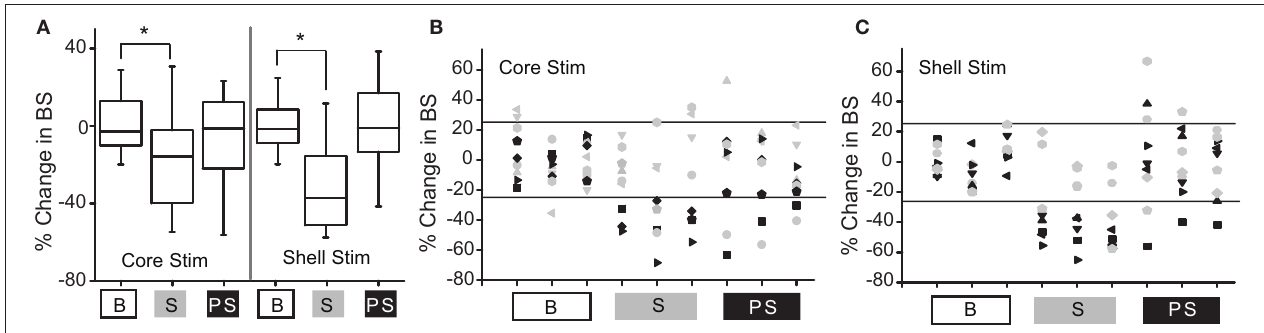
FIGURE 3 | Deep brain stimulation targeted to either the NAc core or shell produces significant reductions in binge size using group-based analysis but with clear individual responders and non-responders. (A) Group-based analysis (RMANOVA) with post-hoc evaluation revealed a significant difference between baseline (B) and stimulation (S) sessions but not between baseline and post-stimulation (PS) sessions with either core or shell targeted stimulation (* p 0.05, boxplots-95% CI). (B) Individual rat responses to core stimulation with responders (black, 4/9) and non-responders (gray, 5/9). Horizontal lines illustrate ± 2 standard deviations ( ± 26%). (C) Individual rat responses to shell stimulation with responders (black, 5/9) and non-responders (gray, 4/9).